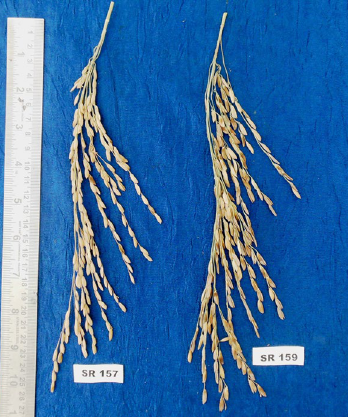
Photo 1. Photograph of panicle of recombinant inbred lines of rice: SR-157 (low sterile) and SR-159 (high sterile).